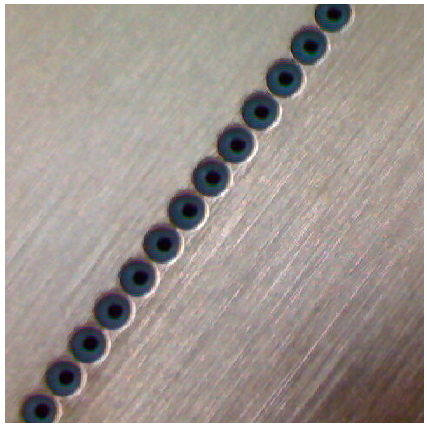
Figure 7. Detail of a row of holes in an Micro-Pattern Gas Detectors (MPGD) plane.